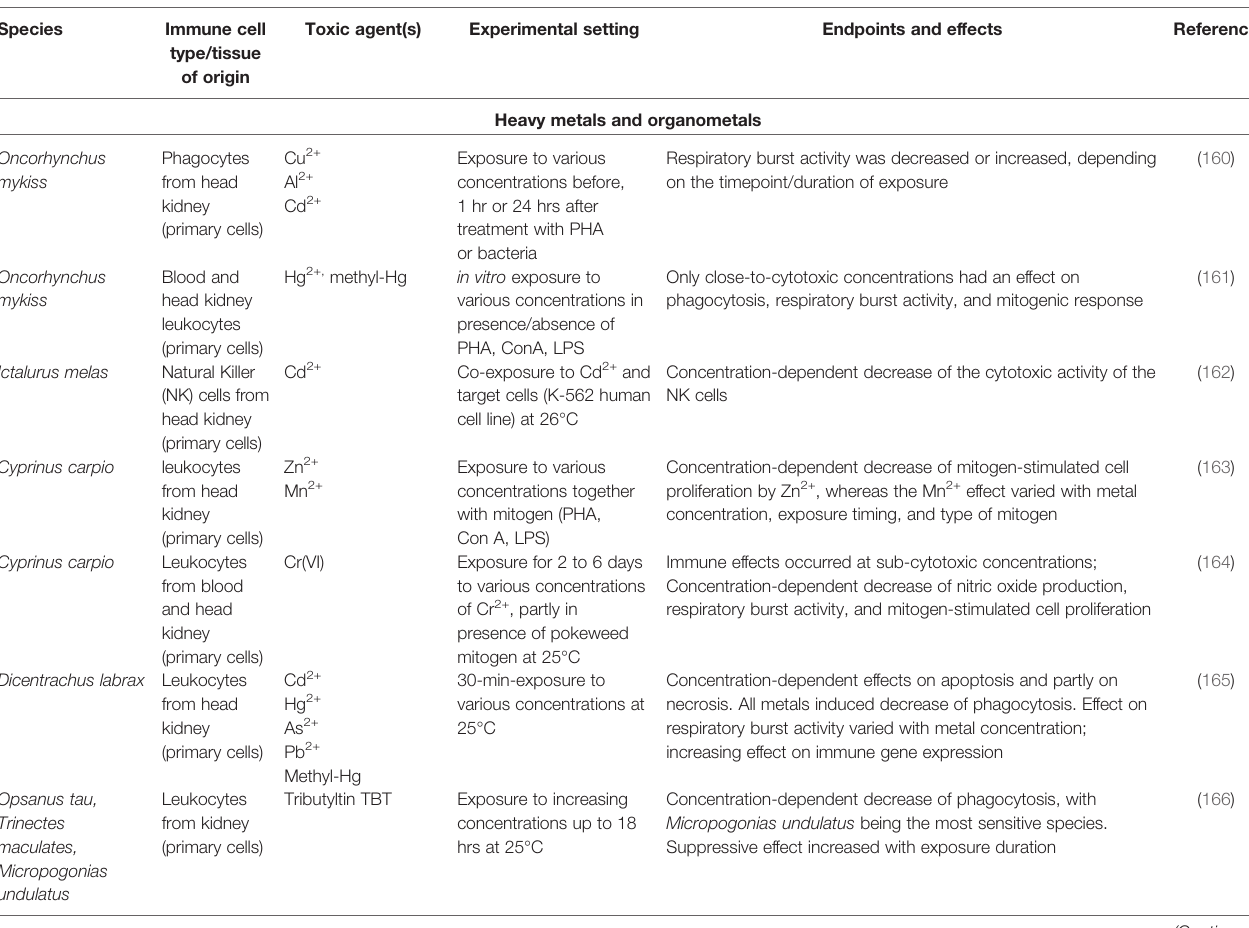
TABLE 2 | Examples of in vitro immunotoxicity studies using fi sh immune